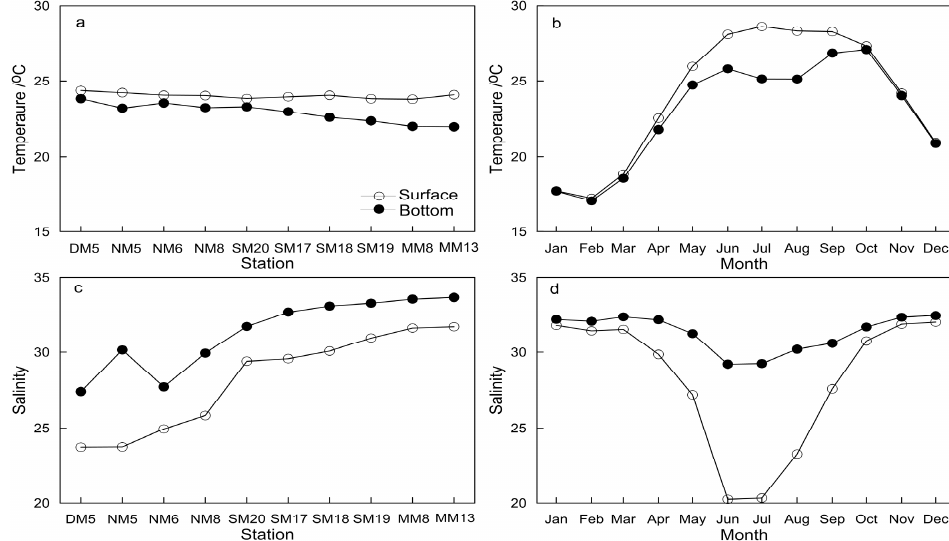
Figure 2. Variabilities of temperature and salinity during the period 2000 − 2017. ( a , c ) Annual average at each station; ( b , d ) monthly average at all stations.